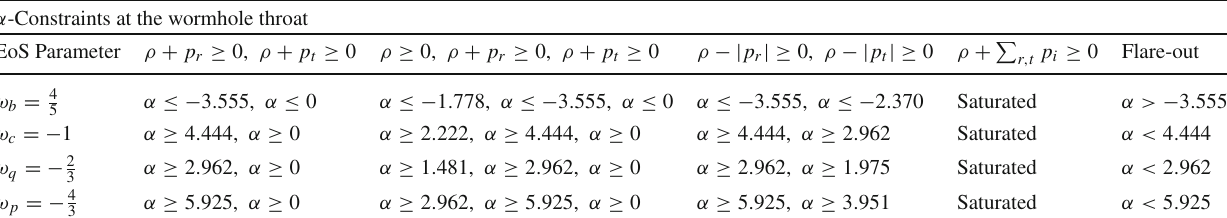
Table 2 The numerical constraints imposed on α by the energy conditions and the flare-out condition, for different values of the EoS parameter ω α -Constraints at the wormhole